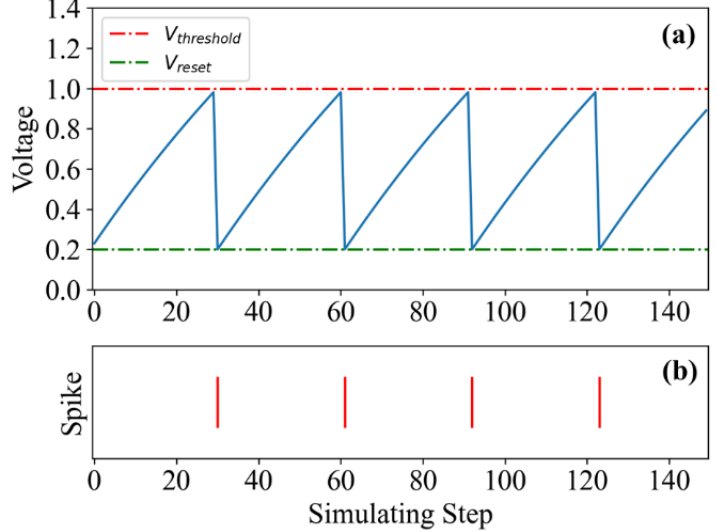
Figure 2. ( a ) The membrane voltage and ( b ) spike output of LIF neurons for X(t) = 2. We consider 30 LIF neurons, and the external stimulus for each LIF neuron is increased linearly with the neuron index as shown in Figure 3a. The observation time step is T = 128. The membrane voltages and the corresponding spikes for the 30 LIF neurons at different time steps are presented in Figure 3b,c. By calculating the firing rate of each LIF neuron, it can be seen from Figure 3d that the firing rate is generally increased with the neuron index. The firing rate of an LIF neuron is used to replace the ReLU